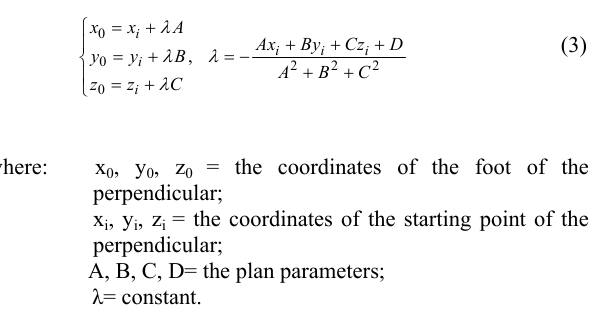
Figure 5. Voronoi diagram polygons calculated for the points that belong to the window’s plan (bottom-right corner) 3.3.5 Automatic Coloring of the Voronoi Diagram Polygons: